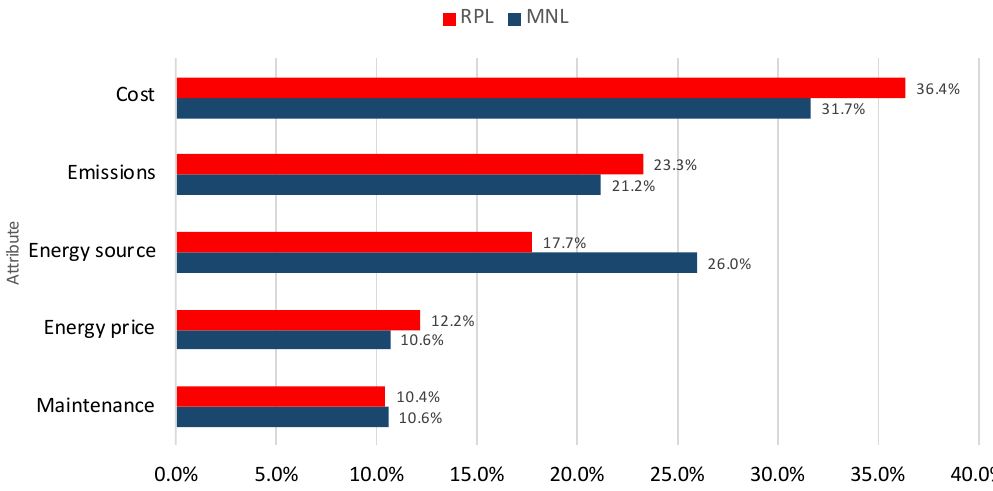
Figure 3. DCE: MNL and RPL models’ estimated relative importance of